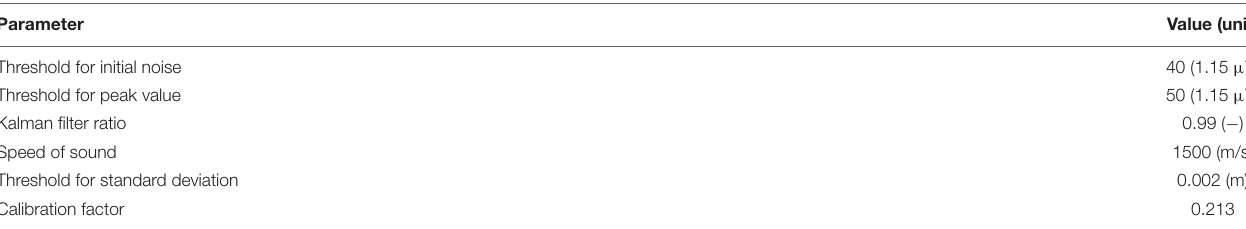
APPENDIX TABLE TA1 | Parameter values for post-processing raw